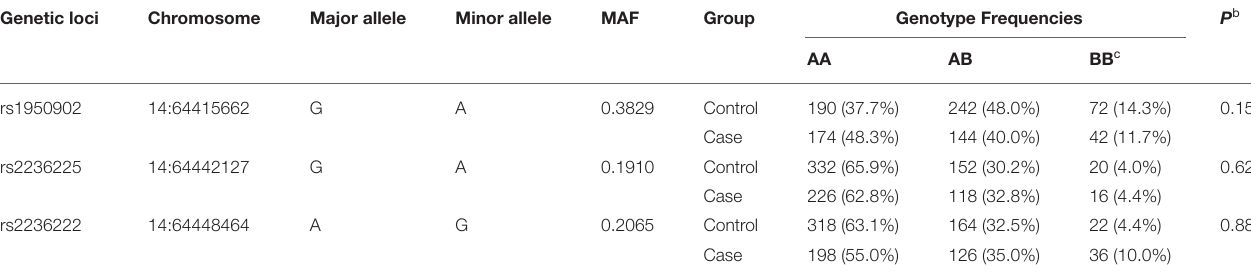
TABLE 3 | Genotypes Frequencies of genetic loci of MTHFD1 gene and Hardy-Weinberg Disequilibrium tests of the control group a . Genetic